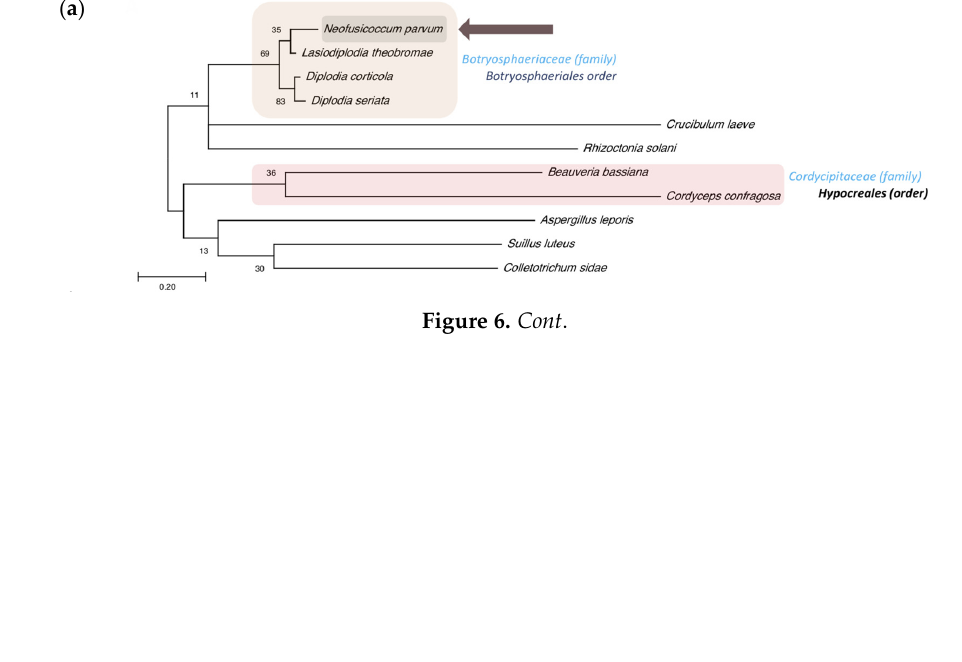
Figure 6 . Phylogenetic analyses of NpCysRP1, NpCysRP2, and NpCysRP3 with orthologs from other fungal species. The phylogenetic trees were constructed using protein sequences with the maximum likelihood method and JTT matrix ‐ based